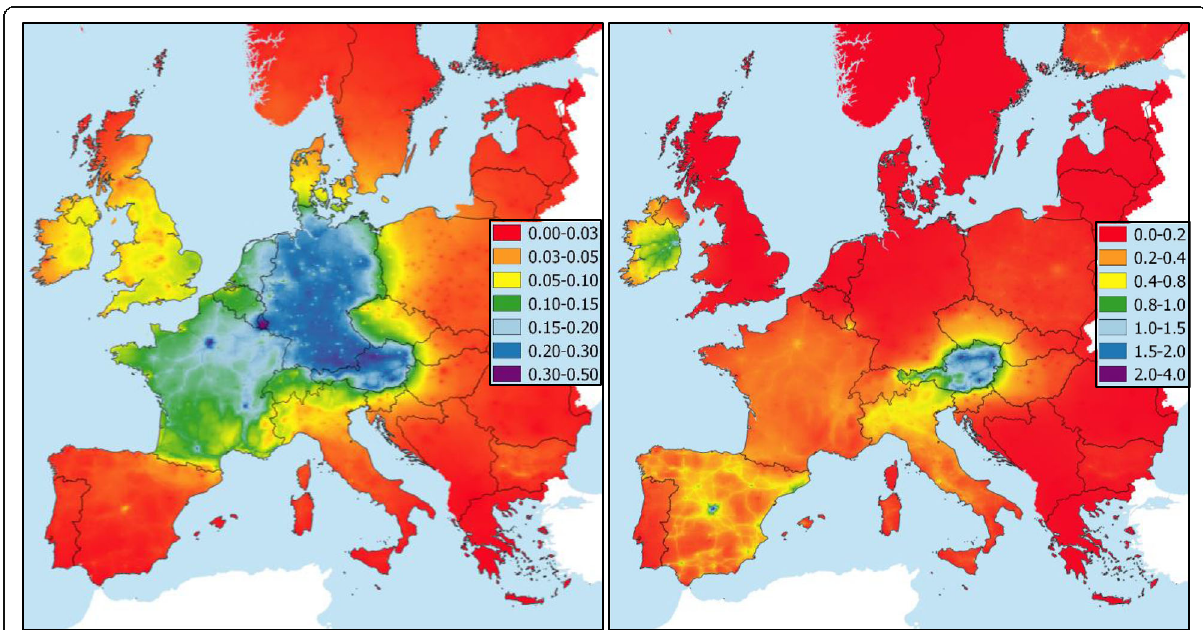
Fig. 10 PM 2.5 concentration reductions [%] in 2020 [left] and 2030 [right] (in the NPF scenario with respect to the base scenario). Source: based on EU [22]. Legend: note the change in